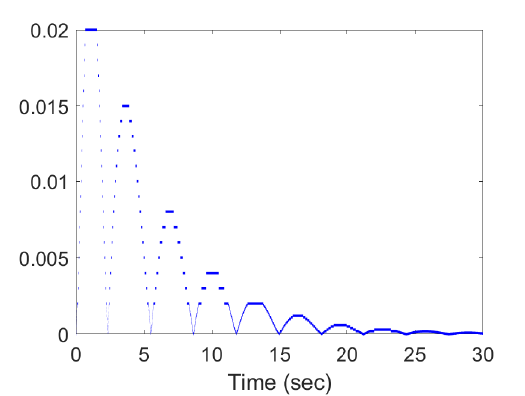
Figure 9. The trajectory of j y ( t ) .